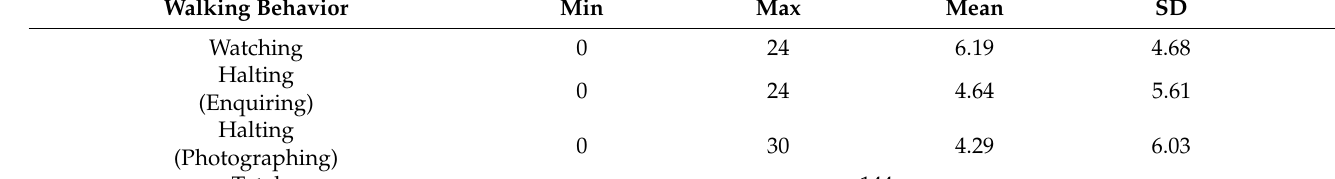
Table 4. The descriptive statistics of the average cumulative intensity of tourists’ walking-stopping behaviors.